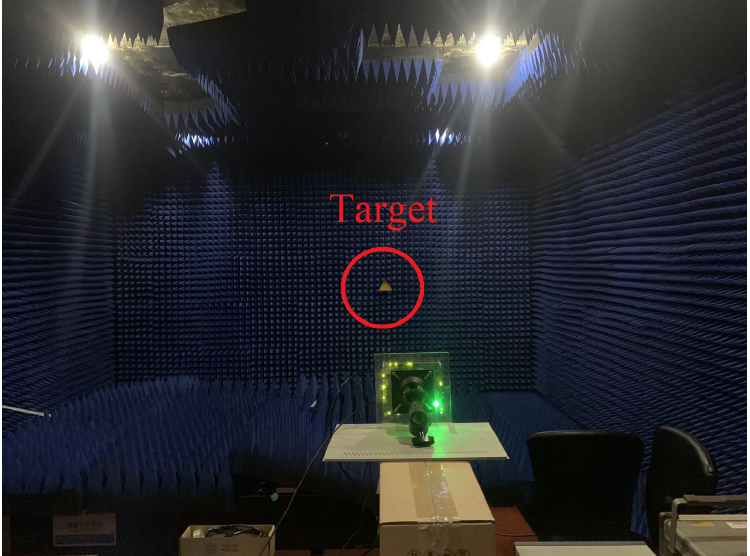
Figure 9. Single target